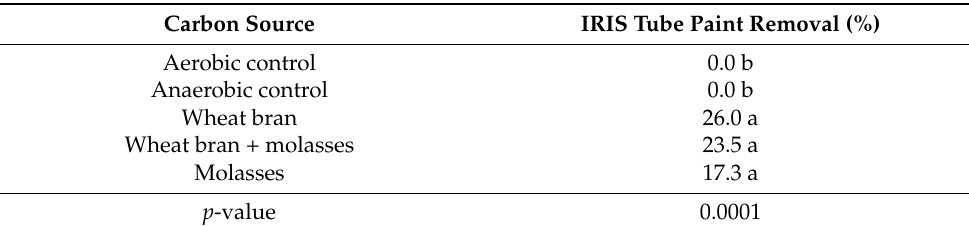
Table 7. Effect of anaerobic soil disinfestation (ASD) with different carbon sources on iron oxide paint removal from Indicator of Reduction in Soils (IRIS) tubes in field trials in Huron